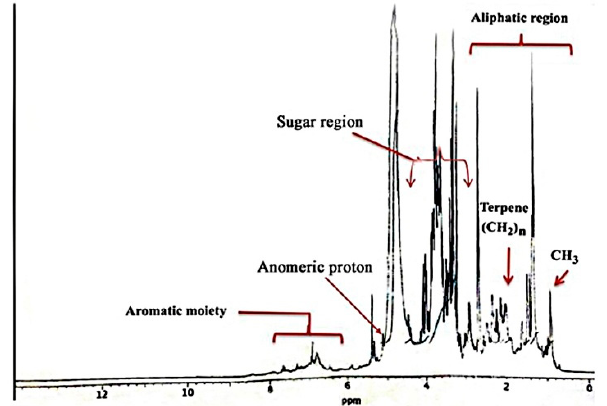
Figure 3. 1 H-NMR spectrum of A. hierochuntica methanolic extract.